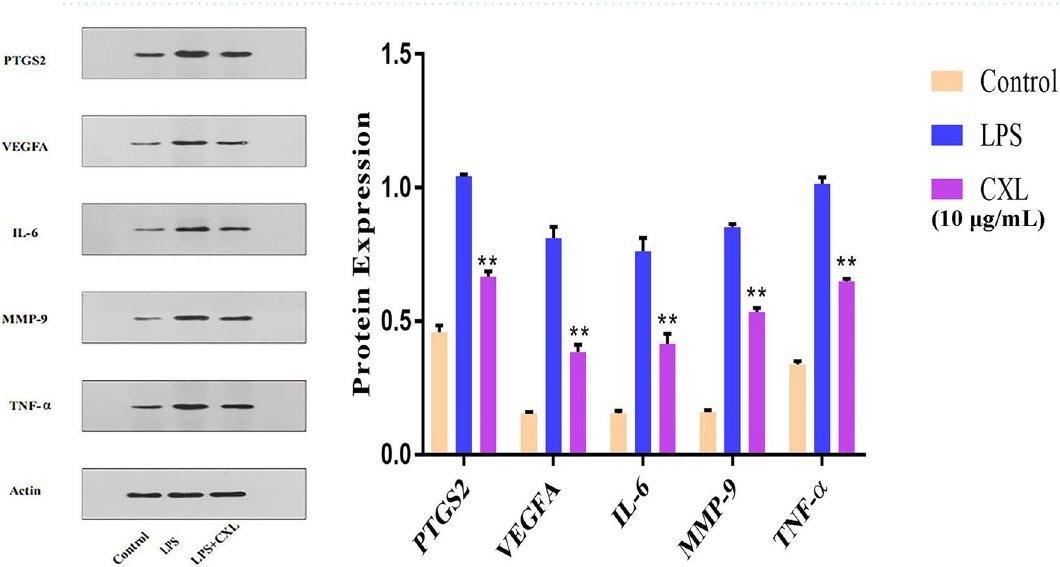
Figure 9. The protein expression of Chuan Xinlian extract on the RAW264.7 based on Western blot analysis (compared with LPS group, * p < 0.05, ** p < 0.01, n =